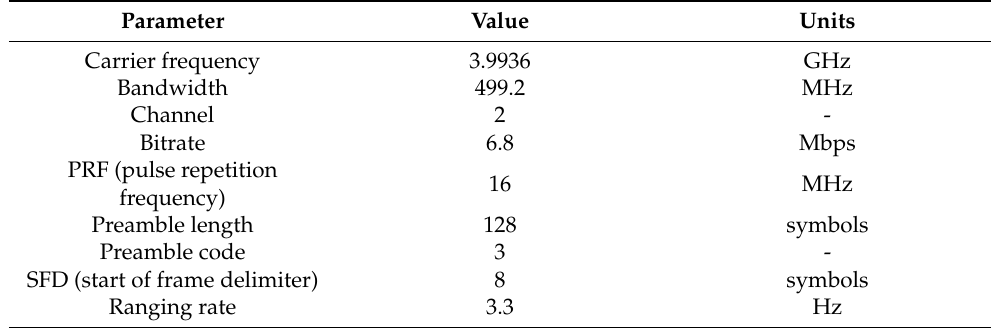
Table 1. Configuration parameters of the UWB system.